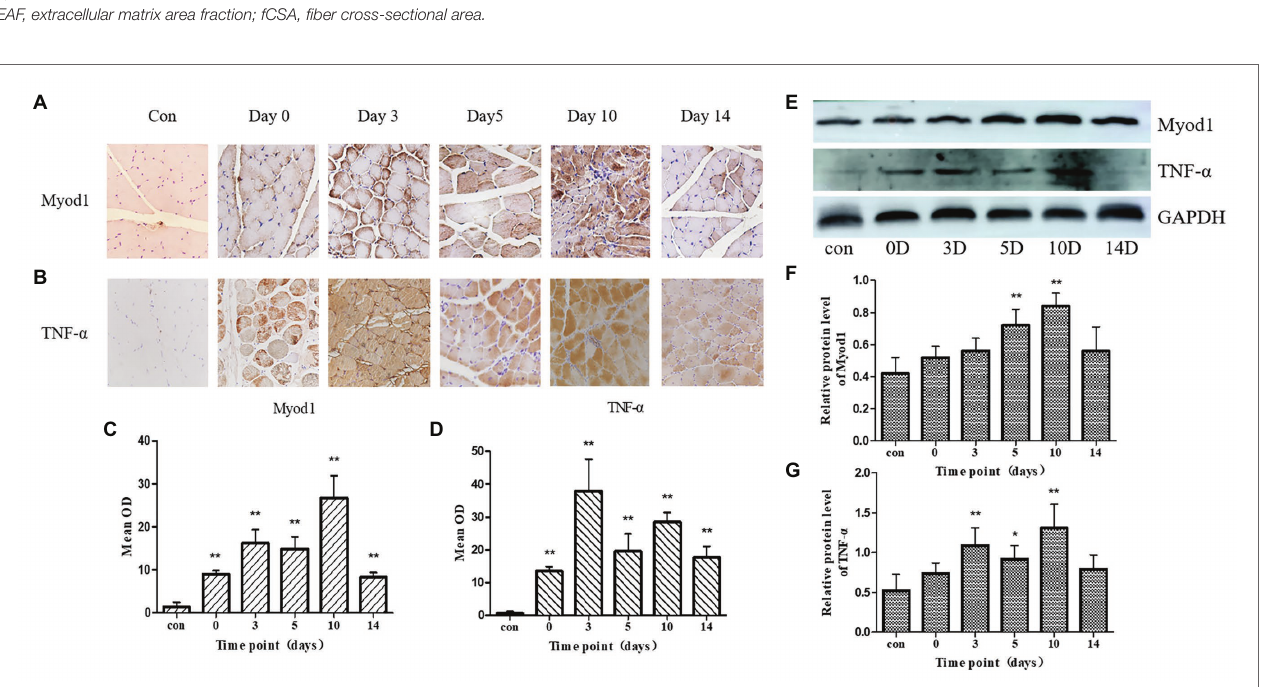
FIGURE 4 | (A,B) : immunohistochemical pictures of Myod1 and TNF- α at control and frostbite (0, 3, 5, 10, and 14 days). (C,D) : mean optical density (OD) of Myod1 and TNF- α in control group and frostbite groups. (E) Western blot pictures of Myod1 and TNF- α . (F,G) : protein expression of Myod1 and TNF- α in control group and frostbite groups. Scale bar, 200 μ m. OD, optical density. * p < 0.05, ** p <